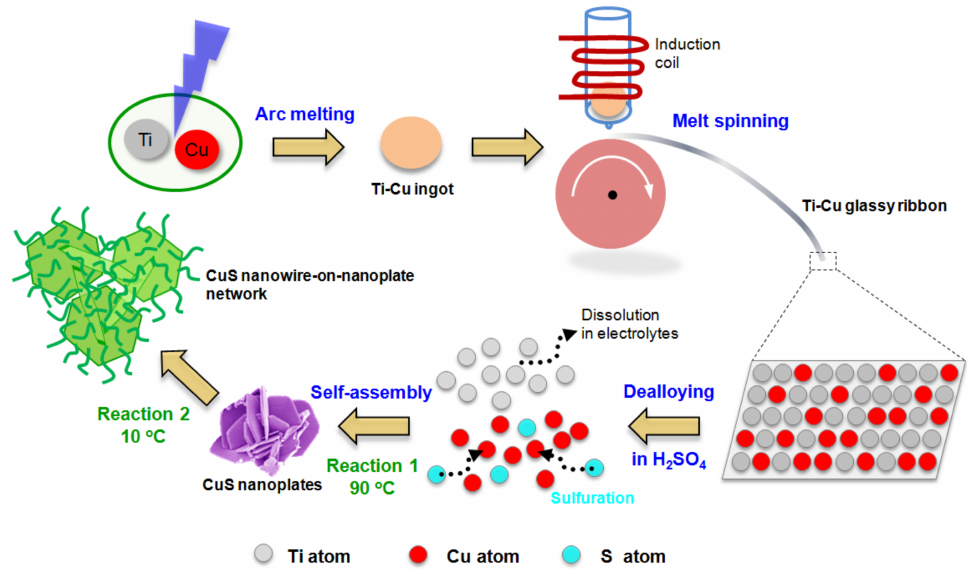
Figure 1. Schematic showing the synthesis process of the CuS nanowire-on-nanoplate